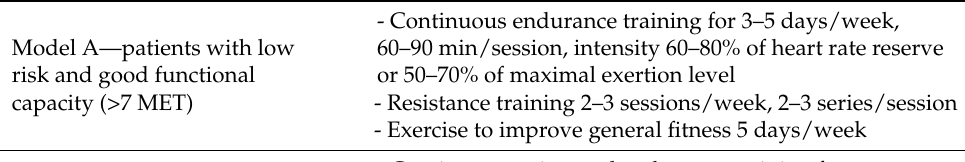
Table 1. Rehabilitation models depending on risk and functional